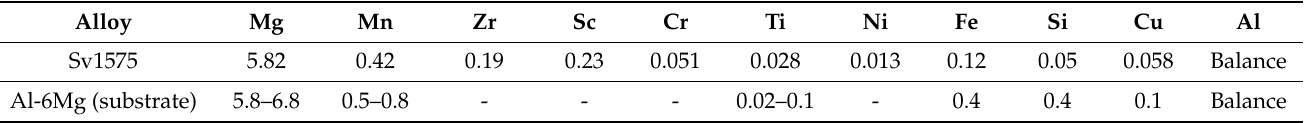
Table 1. Chemical compositions of the welding wire were purchased commercially from LTD Experimental plant «Avial» and Al-6Mg substrate. Alloy